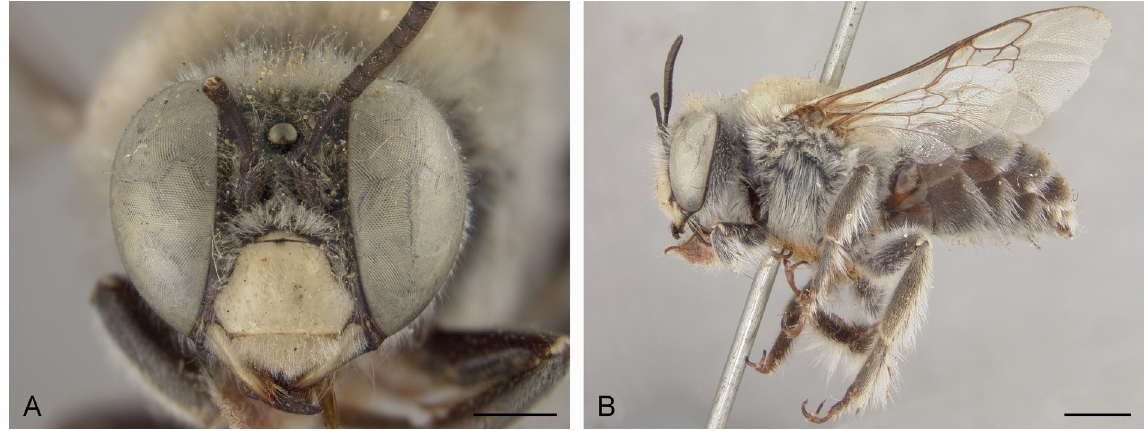
Fig. 22. Centris hoffmanseggiae Cockerell, 1897, lectotype, ♂ (NMNH; USNM ENT 00534200). A . Frontal view. B . Habitus, lateral view. Scale bars: A = 1 mm; B = 2